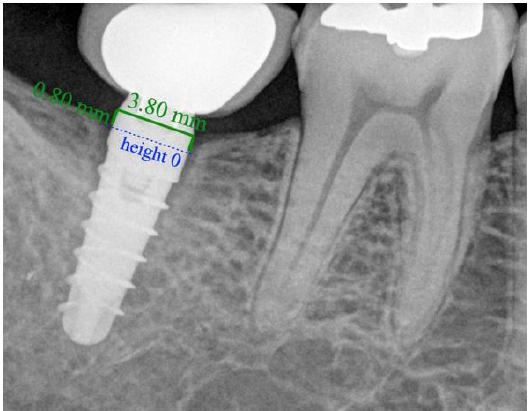
Figure 9. Periapical radiograph after 24 months of prosthetic loading of a supracrestal implant with convergent neck (PRAMA RF) without bone loss.